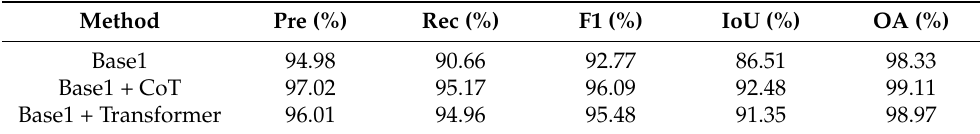
Table 4. Numerical Ablation Base1 Results on CCD